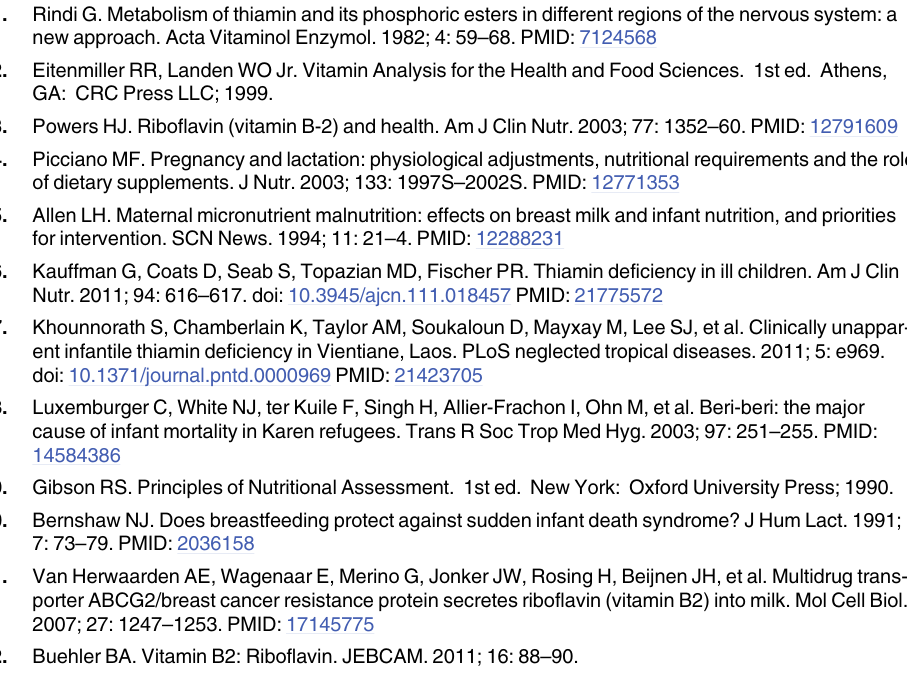
S2 Table. Concentrations of TPP, TMP, thiamin, total thiamin, riboflavin, FAD, and total riboflavin [ μ g/L] in the LNS group at 2/6 weeks. S3 Table. Concentrations of TPP, TMP, thiamin, total thiamin, riboflavin, FAD, and total riboflavin [ μ g/L] in the control group at 24 weeks. S4 Table. Concentrations of TPP, TMP, thiamin, total thiamin, riboflavin, FAD, and total riboflavin [ μ g/L] in the LNS group at 24